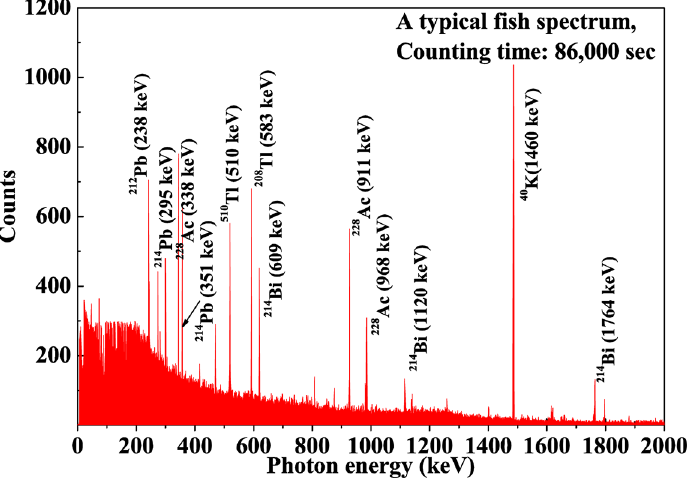
Fig 3. A typical gamma-ray spectrum collected from a fish